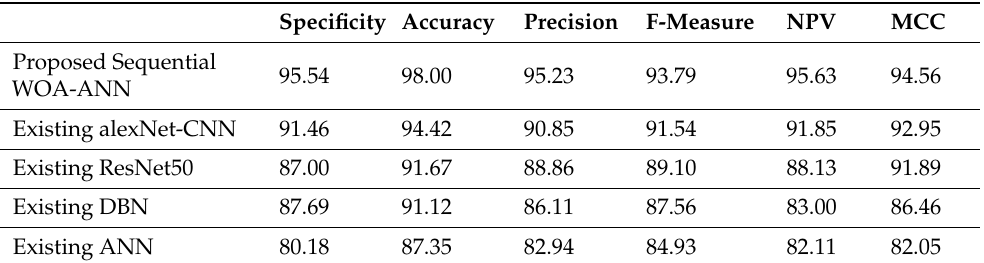
Table 3. Evaluation of classification metrics for proposed sequential WOA-ANN on specificity, accuracy and others.